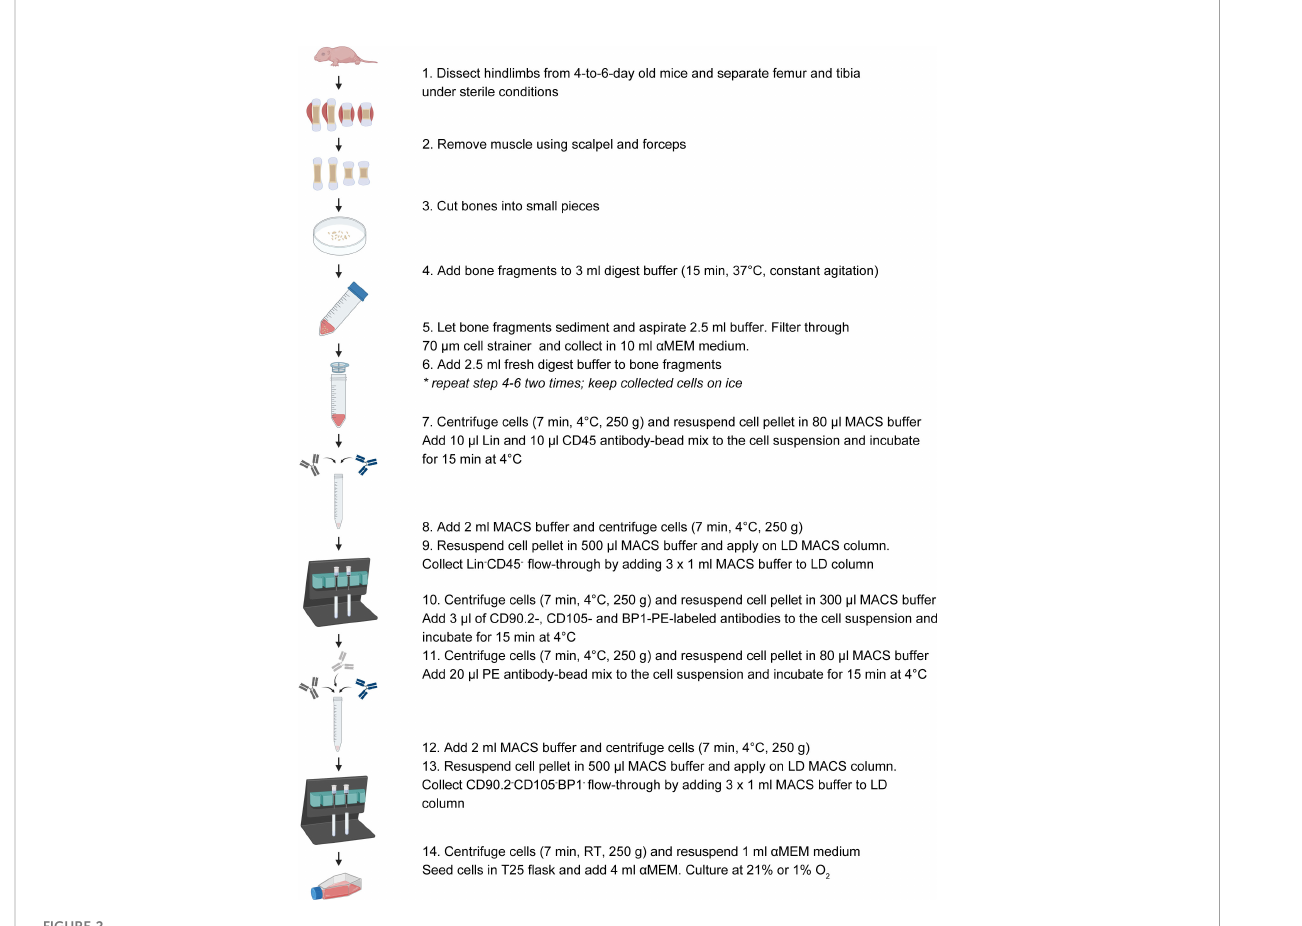
FIGURE 2 Schematic overview of the experimental setup to isolate SSPCs from neonatal long